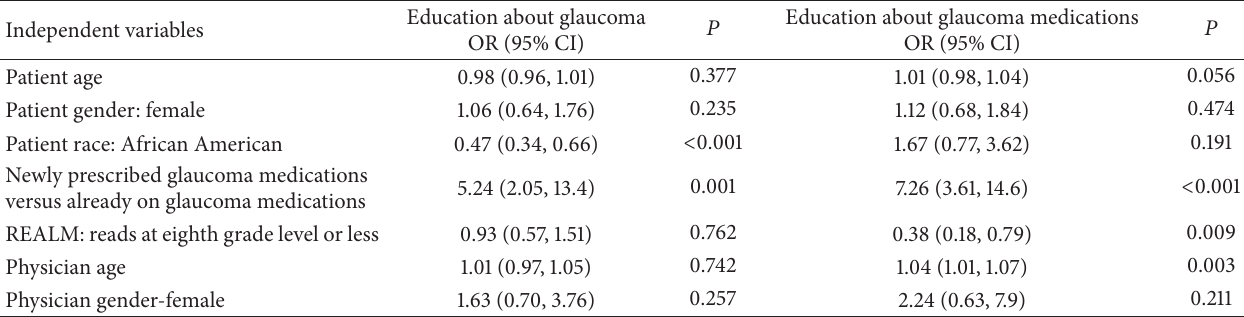
Table 4: Generalized estimating equation results predicting whether providers educate the patients about glaucoma and glaucoma medications ( 𝑁 = 279